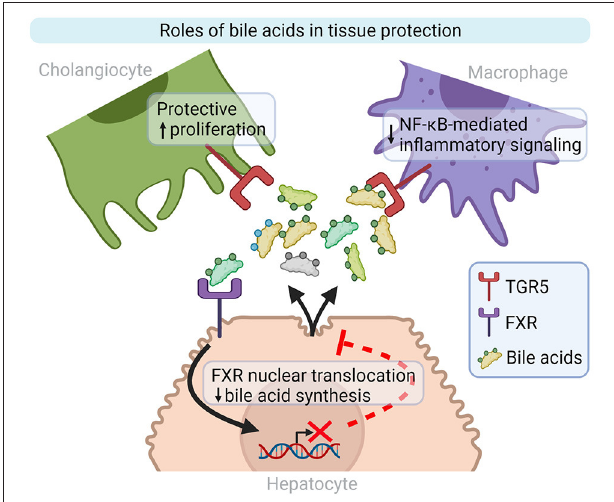
FIGURE 2 | Bile acid roles in inflammation and tissue repair modulation. TGR5 and FXR are two well-characterized bile acid receptors implicated in liver homeostasis. TGR5 activation on cholangiocytes and macrophages stimulates cell proliferation and decreases inflammatory signaling, respectively. Bile acid synthesis by hepatocytes is repressed by FXR activation. FXR, Farnesoid X-Activated Receptor; NF- κ B, Nuclear factor kappa-light-chain-enhancer of activated B cells; TGR5, also known as GPBAR1, G-protein-coupled bile acid receptor. Created with